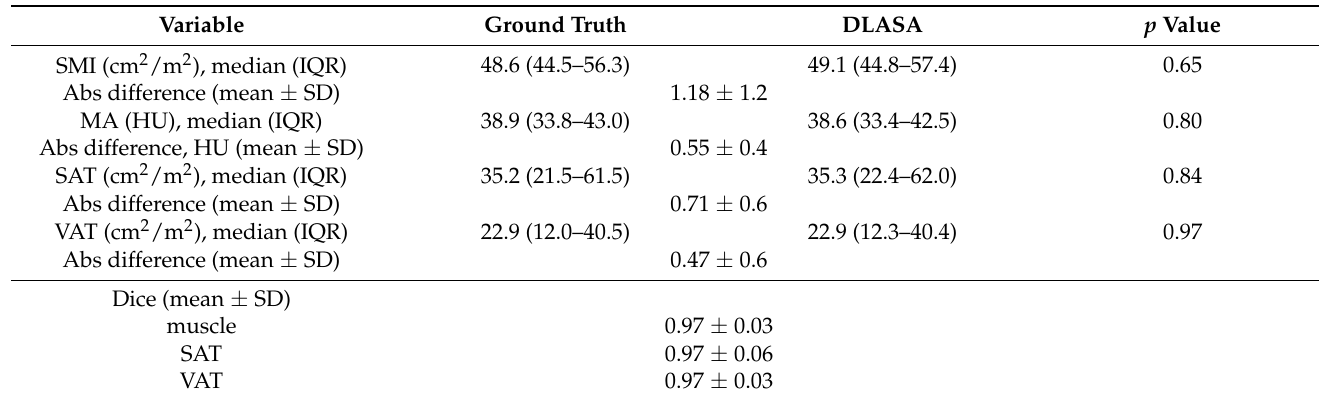
Table 1. Algorithm performance for CT segmentation.